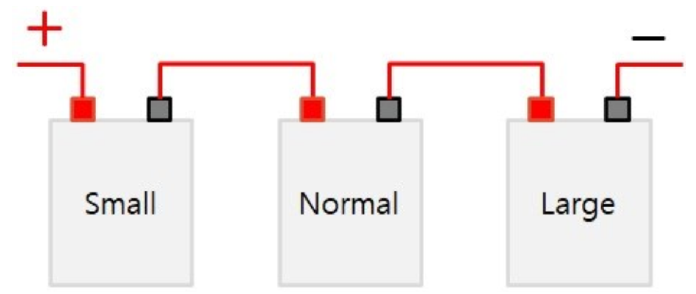
Figure 1. Series connection of